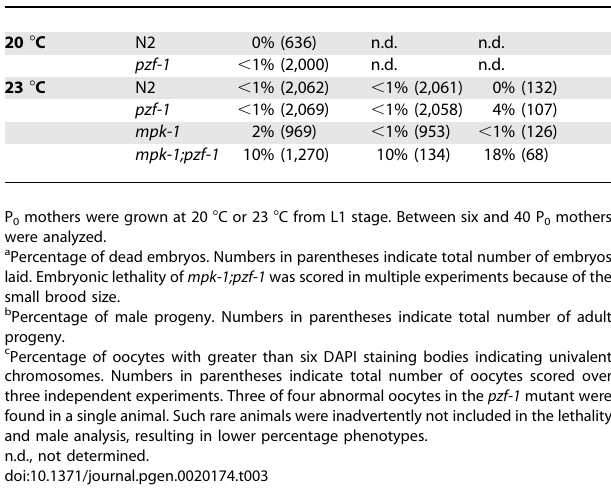
Table 3. Meiotic Segregation Defects in mpk-1;pzf-1 Mutants Temperature Genotype % Embryonic Lethality a